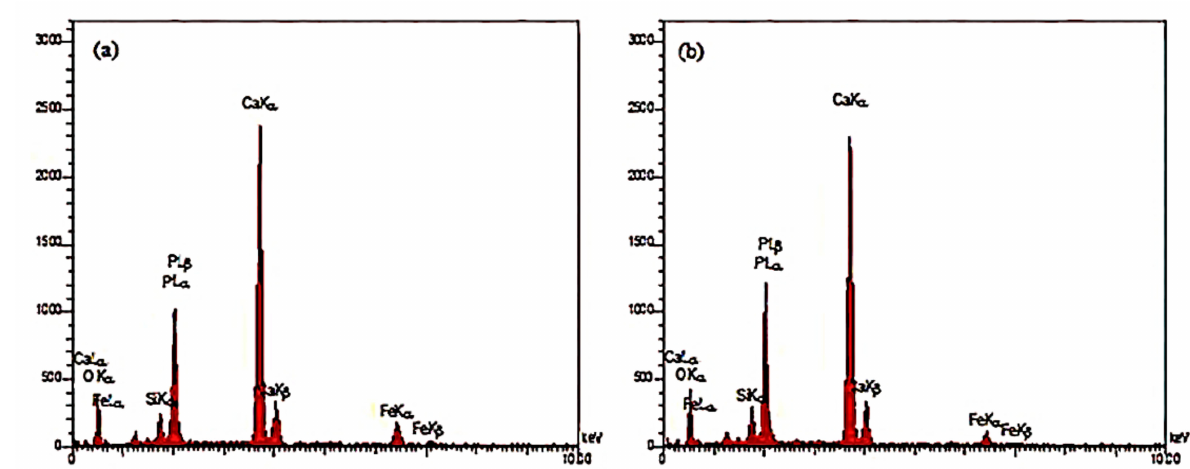
Figure 7. EDX spectra of: ( a ) NP and ( b ) 6-recycled